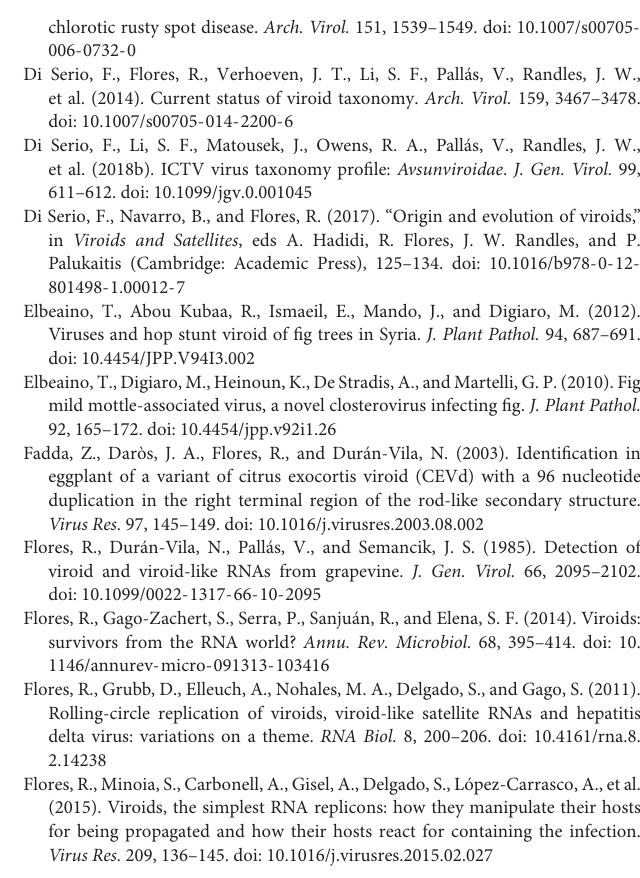
FIGURE S2 | (A) Pairwise comparison between a short and a long viroid-like RNA (Vd-LRNA) identified in silico in a fig sample from the island of Kauai. Positions with identical nucleotides are denoted by asterisks. (B) Primary and predicted secondary structure of the free energy of the long and short Vd-LRNA variants from Kauai. Differences between both RNA molecules are denoted in red. Regions involved in the formation of ( + ) and ( − ) hammerhead structures are delimited by